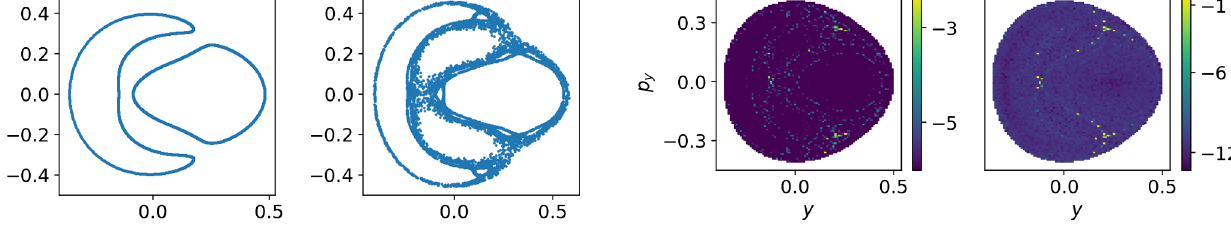
FIG. 2. Poincar´e section of particles starting from x ¼ 0 . 0 , ¼ 0 . 0 and p y ¼ − 0 . 15 , p determined by the condition H ¼ E y x where E ¼ 1 = 12 for the left and E ¼ 1 = 9 for the right.